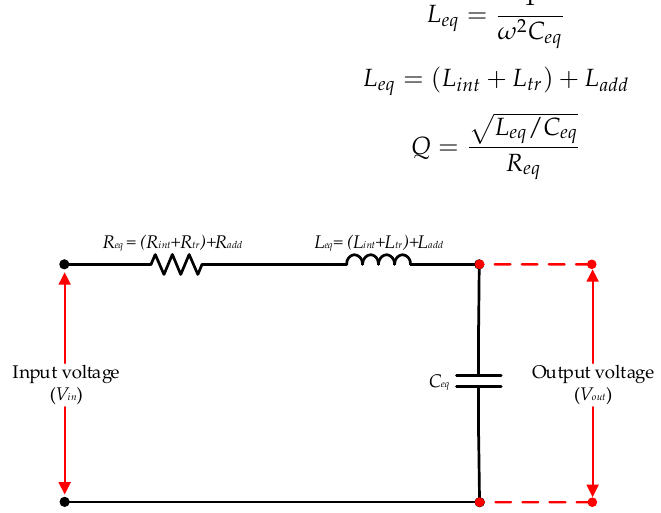
Figure 9. The simplified circuit of the resonant testing system.